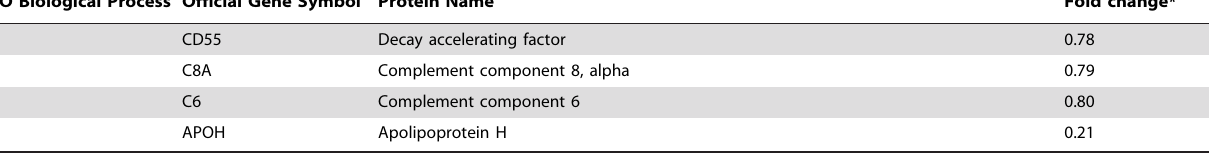
Table 4. Early-phase ARDS Non-Survivor Ontology Groups and Associated Proteins.